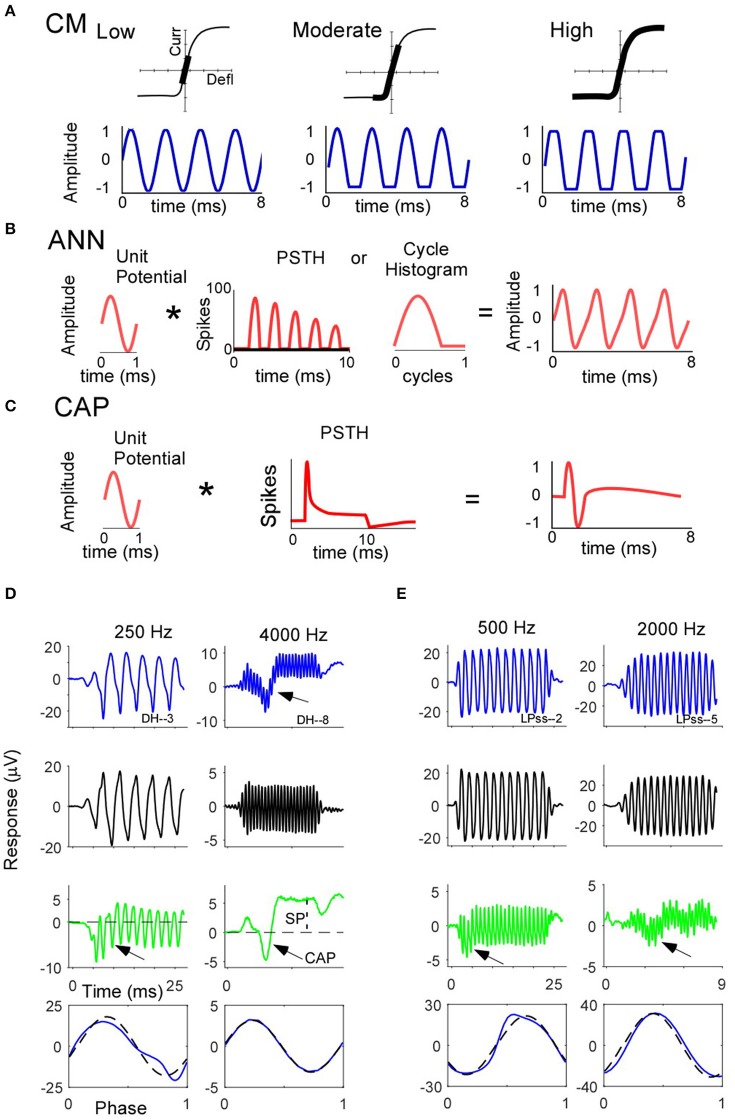
Schematics of the sources of the CM, ANN, and CAP (A–C) and examples of ECochG responses obtained from two CI subjects (D,E). (A) Typical input-output function of hair cell transduction (top row) producing asymmetries in saturation points as a function of intensity (bottom row). (B) The ANN is produced by the convolution (*) of a unit potential, or shape of an action potential as it appears at the round window, and the cyclic response to a low frequency in the population of unit responses, which is equivalent to the cycle histogram. The waveform expected is shown to the right. (C) The CAP is produced by the convolution (*) of the unit potential and well-timed onset responses in the population. (D,E) Responses from two subjects to a low and a high frequency tones. For each subject and frequency, the first three rows are, respectively, the responses to condensation phase of stimulation, the difference between the responses to condensation and rarefaction phases (not shown), and the sum of the responses to the two phases. The fourth row depicts an “average cycle” which is the average of all cycles from condensation phase stimuli in a window after the CAP, and from rarefaction stimuli after flipping and shifting the response in time to match that of the condensation phase. See text for further explanation of features identified in these examples.